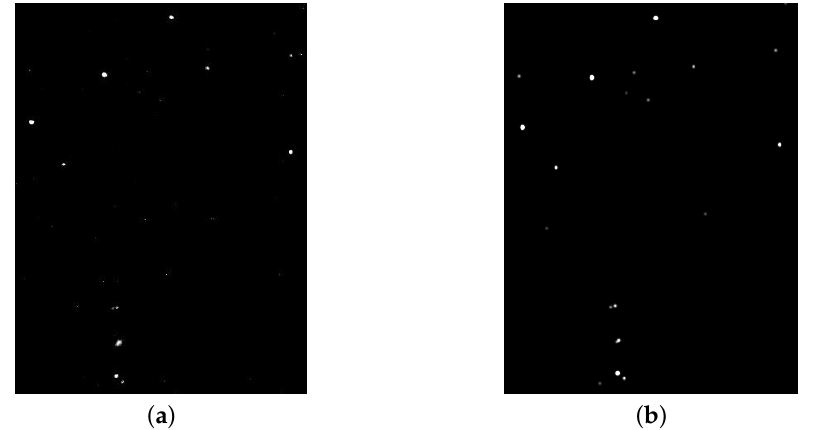
Figure 4. Comparison of ( a ) a real star image, from the ASTERIA CubeSat, JPL/NASA; with ( b ) a synthetic image generated by our star simulator. The images show part of the Orion